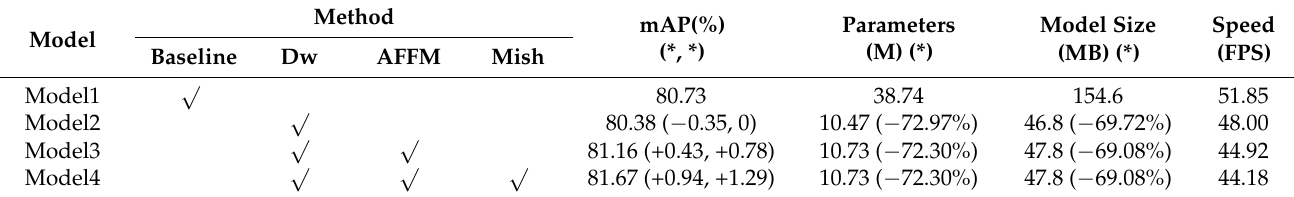
Table 4. Results of ablation experiments on the PASCAL VOC2007 test